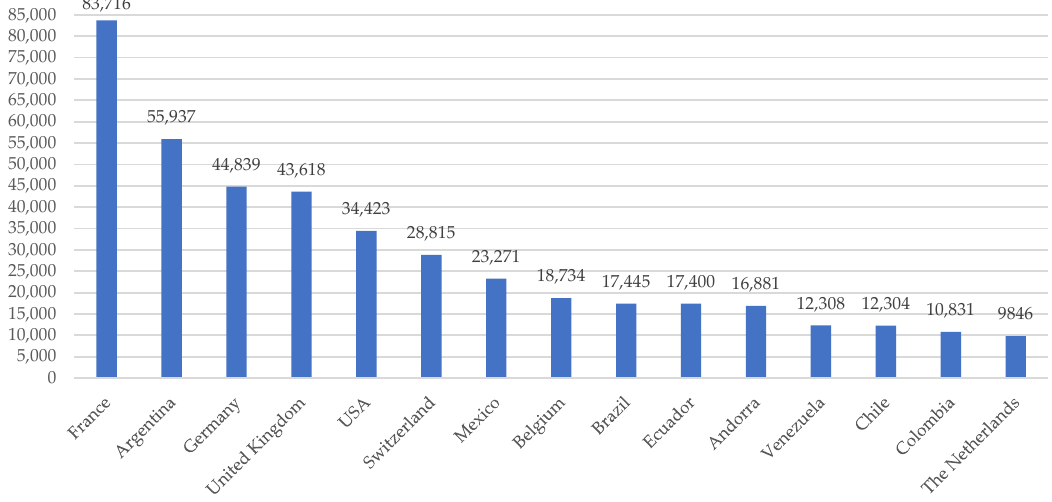
Figure 4. Number of CatS living abroad during 2021 (INE (Instituto Nacional de Estad í stica) 2022).